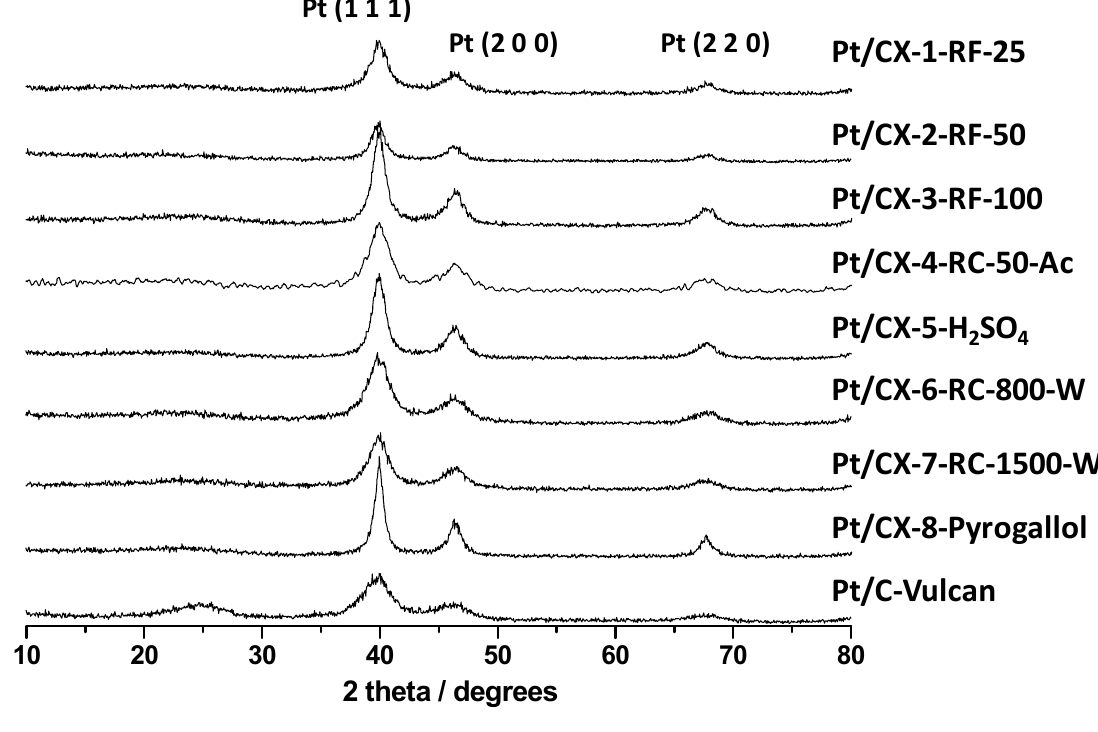
Figure 4. Diffractograms obtained by XRD for the synthesized Pt catalysts.